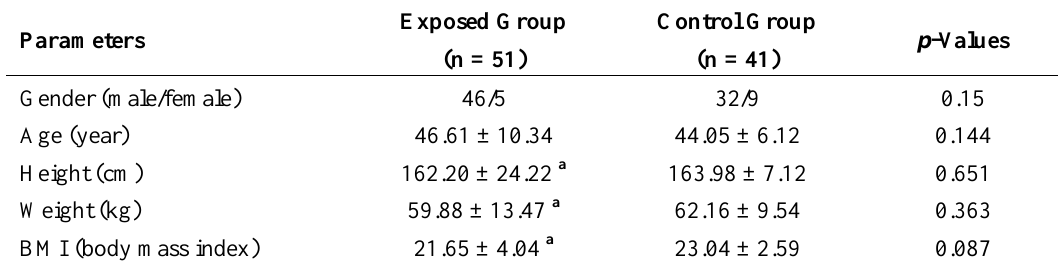
Table 1. Basic demographic characteristics of workers from the exposed group and control group (Mean ±